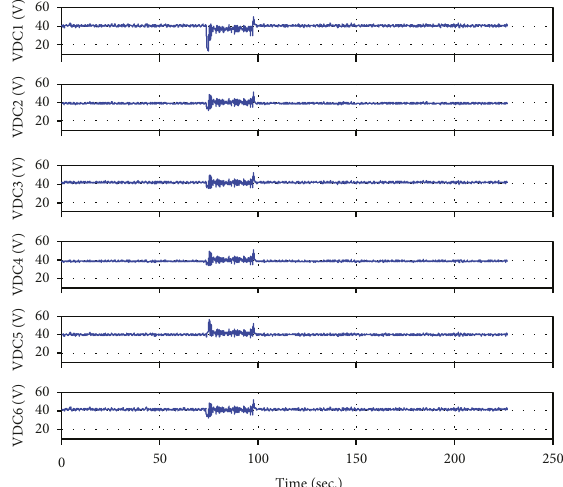
Figure 22: DC-link voltages with nondistributed MPPT control.